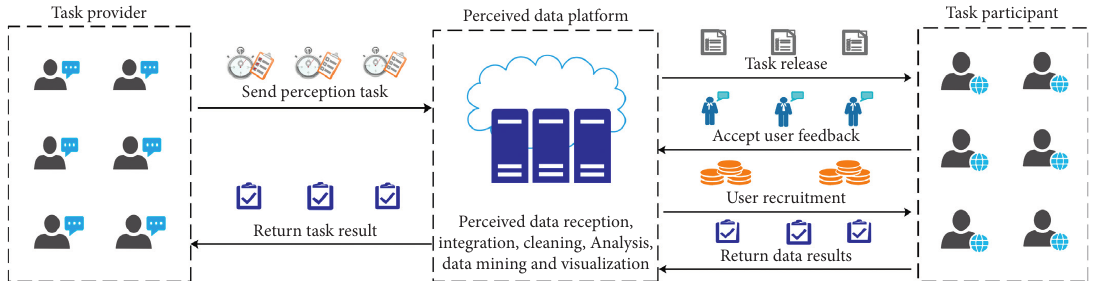
Figure 1: Model diagram of a mobile sensing